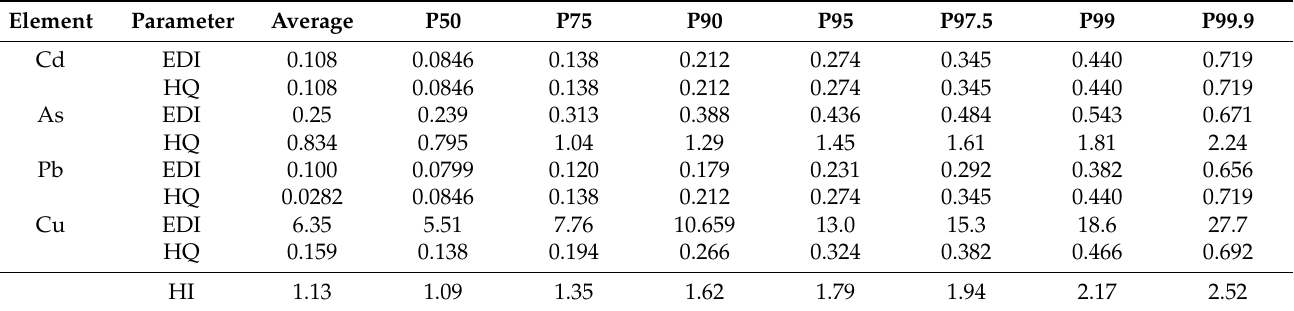
Table 2. The estimated EDIs ( µ g/kg bw/day), HQs, and HIs for exposure to Cd, As, Pb, and Cu via rice consumption in